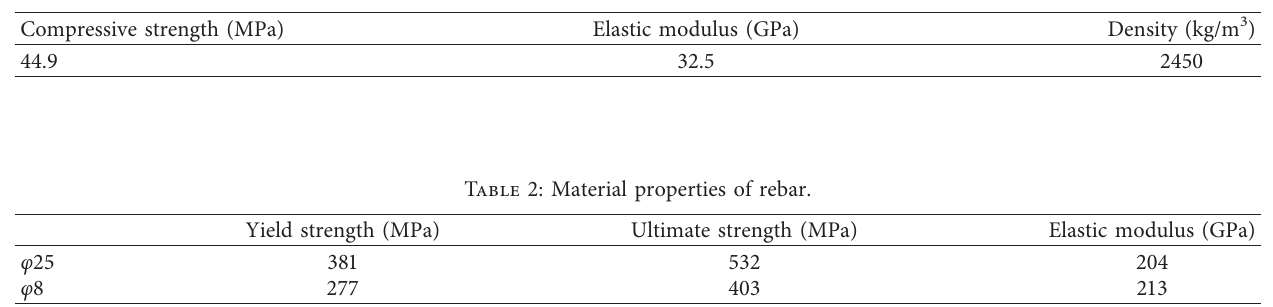
Table 1: Material properties of concrete.